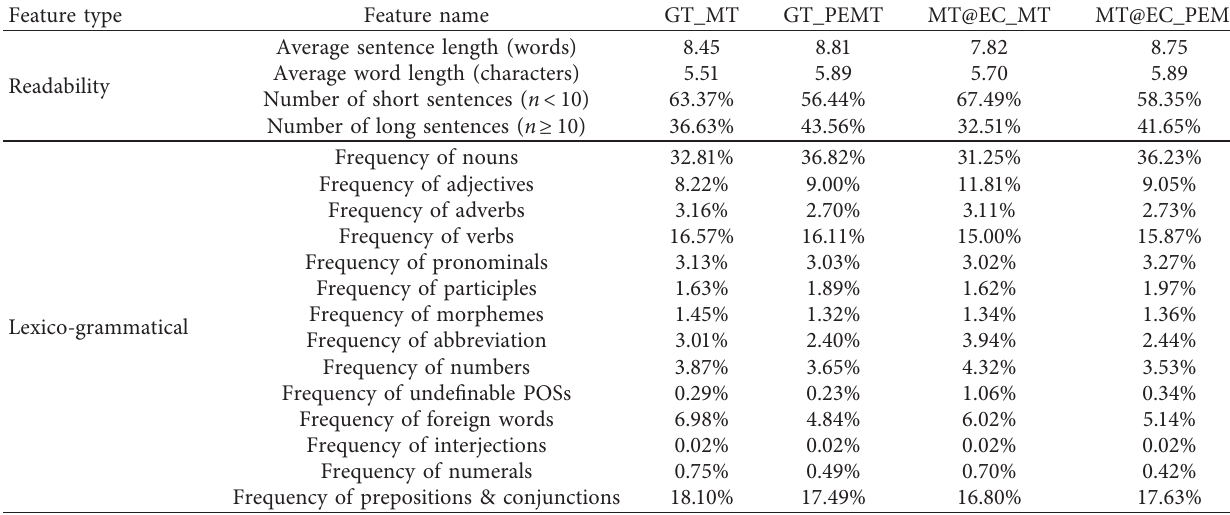
Table 1: Dataset